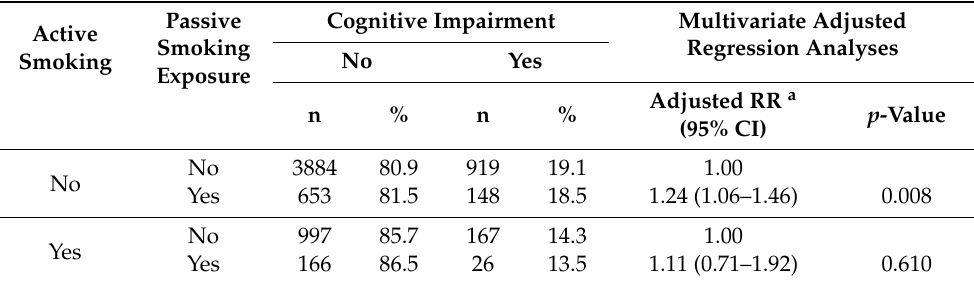
Table 3. Stratified analysis of the relationship between passive smoking exposure and cognitive impairment with respect to active smoking (ZJMPHS Program, Zhejiang, China).